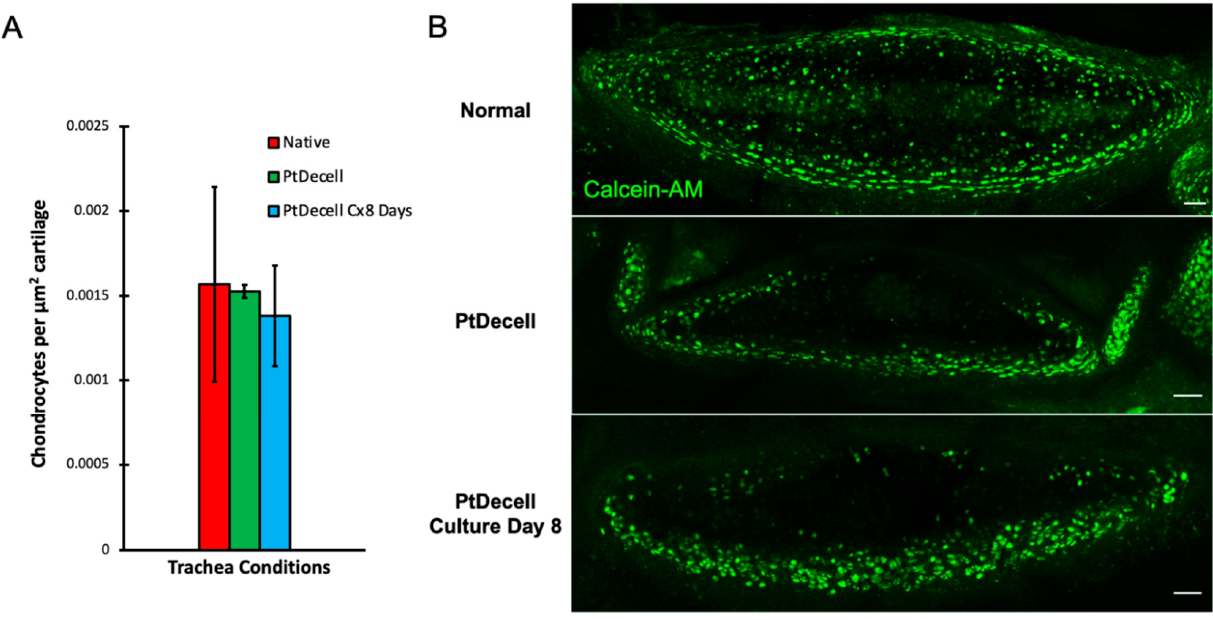
Figure 8. Cartilage viability as determined by a Calcein-AM assay. ( A ) Chondrocyte quantification per unit area of cartilage showed no significant difference between the native and partly decellularized condition ( p > 0.5) and no significant difference between decellularized tracheas and those cultured for 8 days ( p > 0.45). ( B ) In the cross-section, fluorescence is a marker of Calcein-AM metabolism and thus viability. There was notable decrease in viability on the luminal rim of the chondrocytes in the partly decellularized and 8-day culture conditions. This is consistent with prior studies, suggesting cell death in portions of the trachea in closest proximity to the cytotoxic detergents. Scale bar: 50 µ